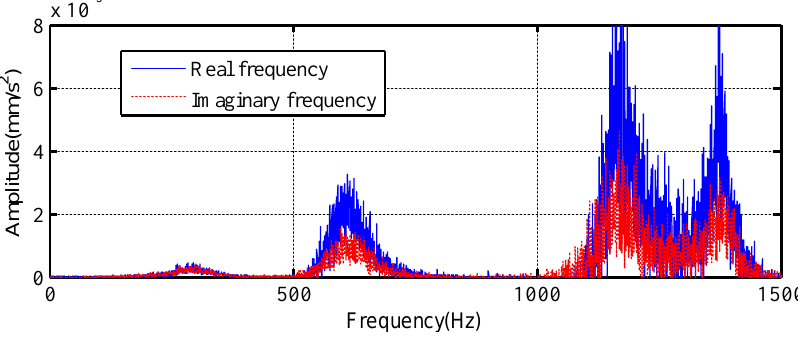
Figure 14. Marginal spectrum of x -direction IMFs.